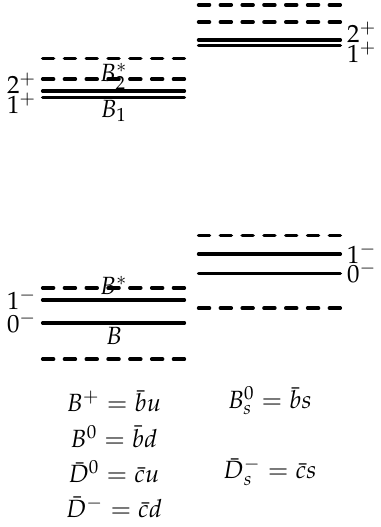
Figure 5. Mesons with ¯ b (solid lines) and ¯ c (dashed